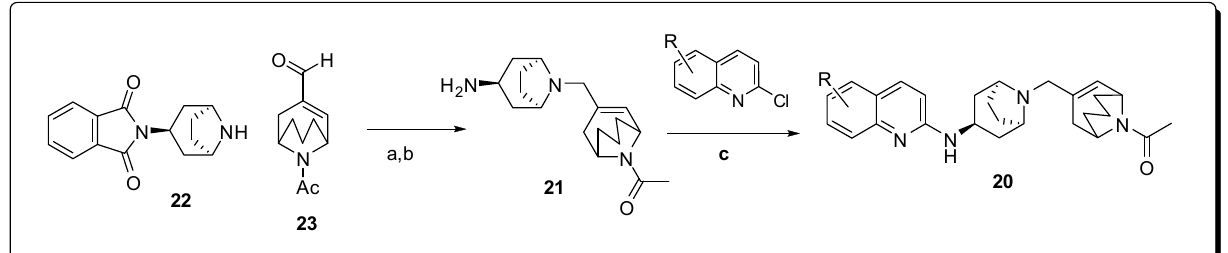
Figure 7. Anti-inflammatory 2-aminoquinolines obtained using